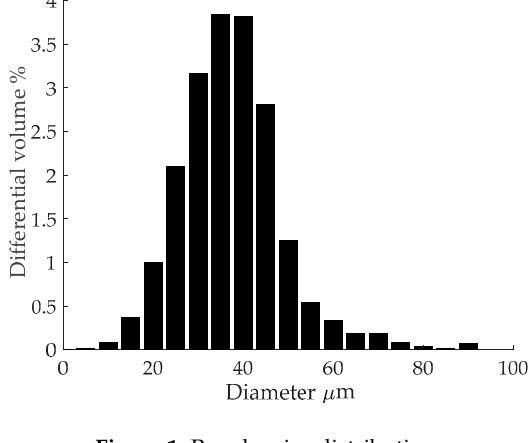
Figure 1. Powder size distribution. Table 1. Powder elemental composition (weight %).